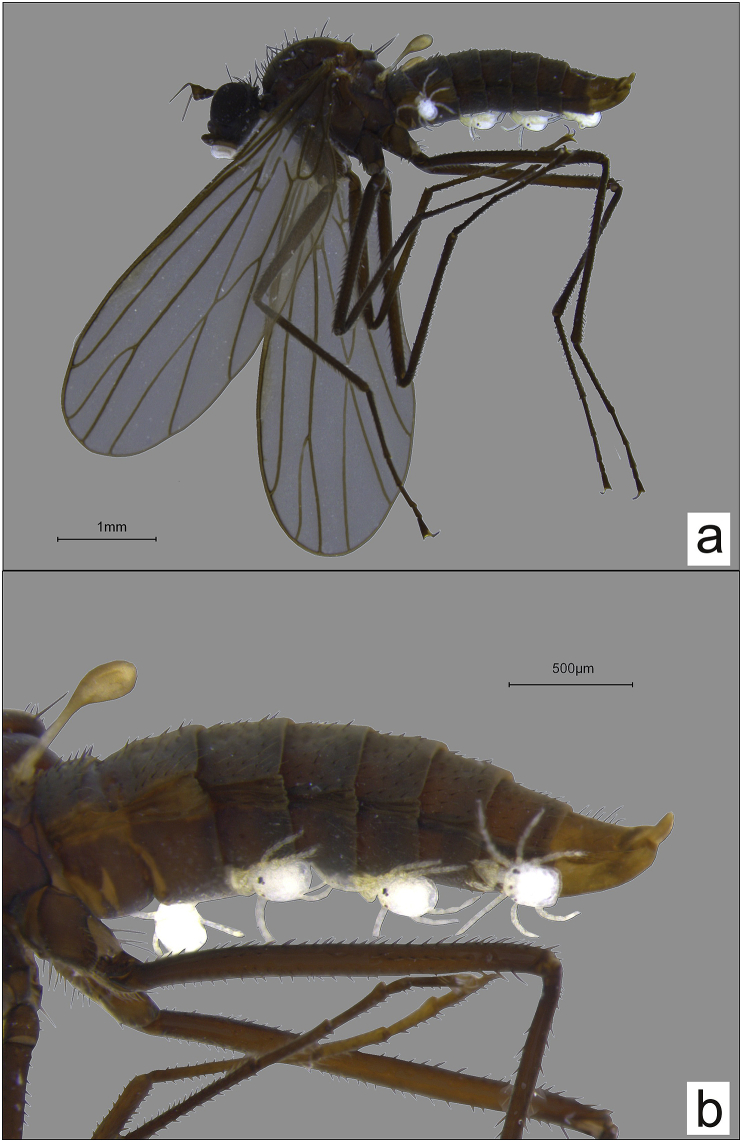
Wiedemannia mikiana parasitized by Panisopsis curvifrons; a – habitus, b – abdomen.